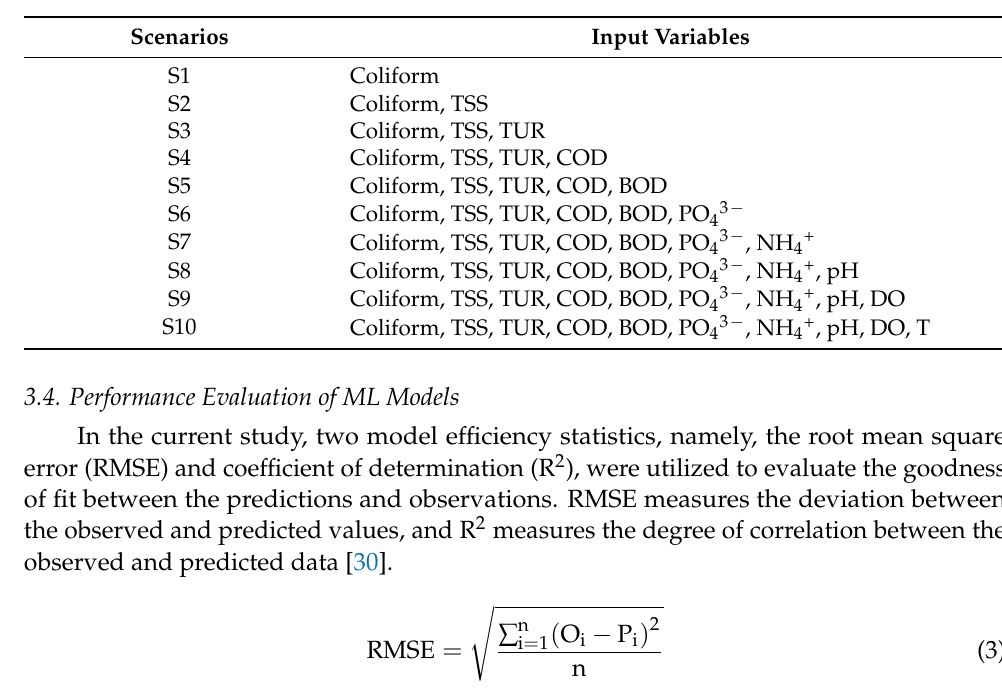
Table 3. Scenarios of input variables for the current